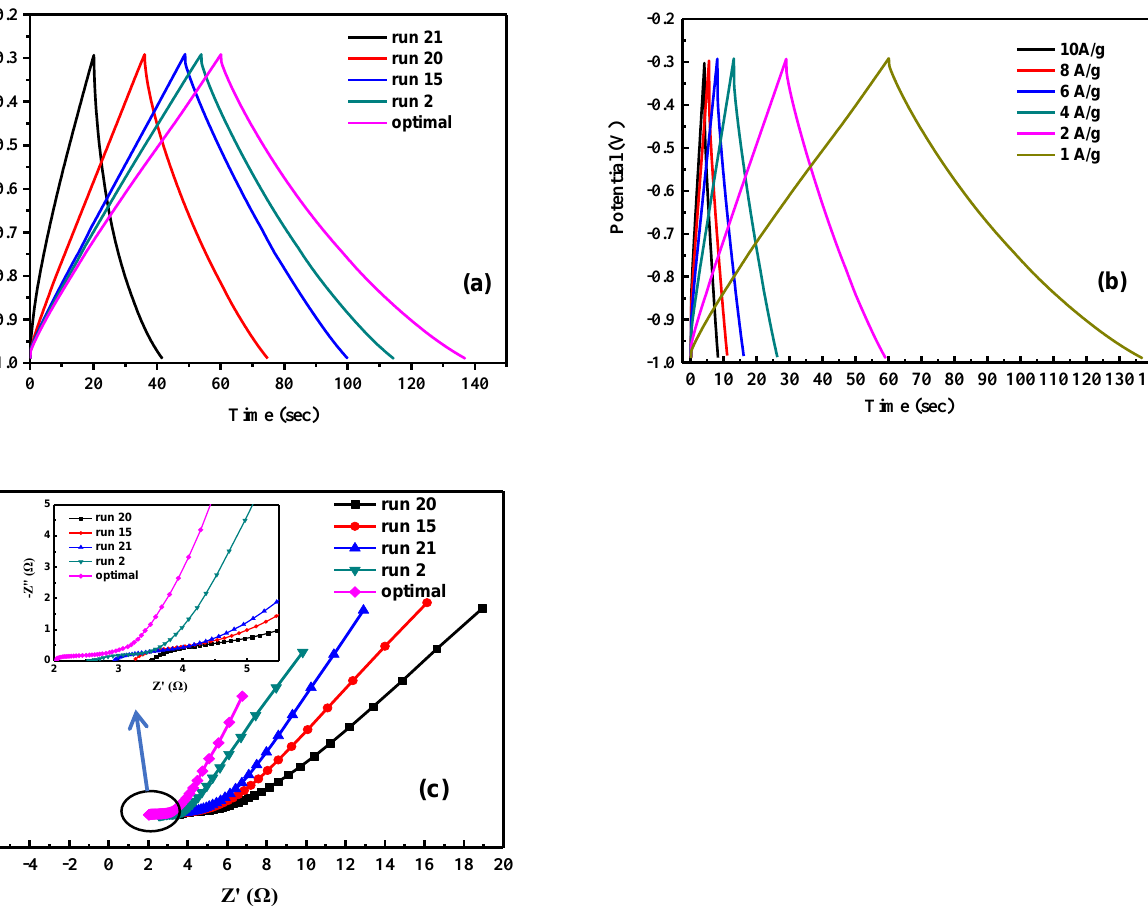
Table 7. Properties of the as-obtained activated carbon.